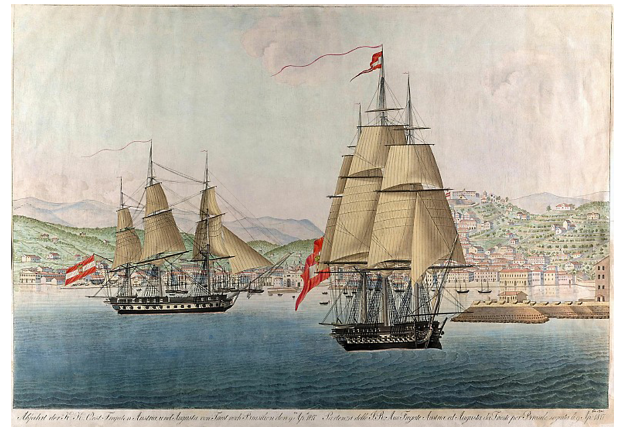
Figure 11. The frigates Austria and Augusta in the port of Trieste on 9 April 1817 in a coloured engraving by G. Passi. Source: Öster- reichische Nationalbibliothek (Bildarchiv und Grafiksammlung, PK 286), Vienna,